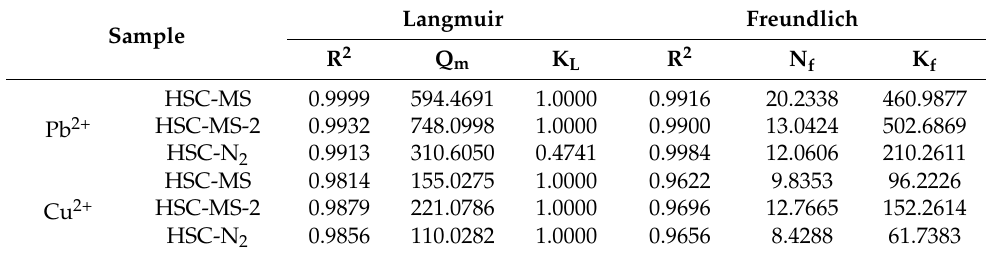
Table 5. Langmuir and Freundlich constants and correlation coefficients (R 2 ) for Pb 2+ and Cu 2+ adsorption on HSC-N 2 , HSC-M and